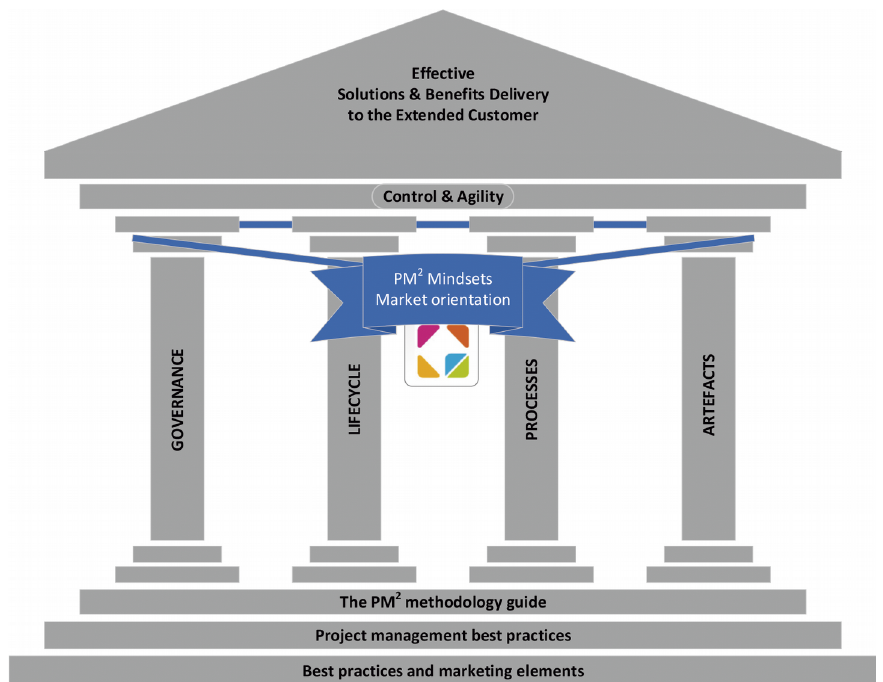
Figure 2. The PM 2 House for sports events. Extended from (European Commission,